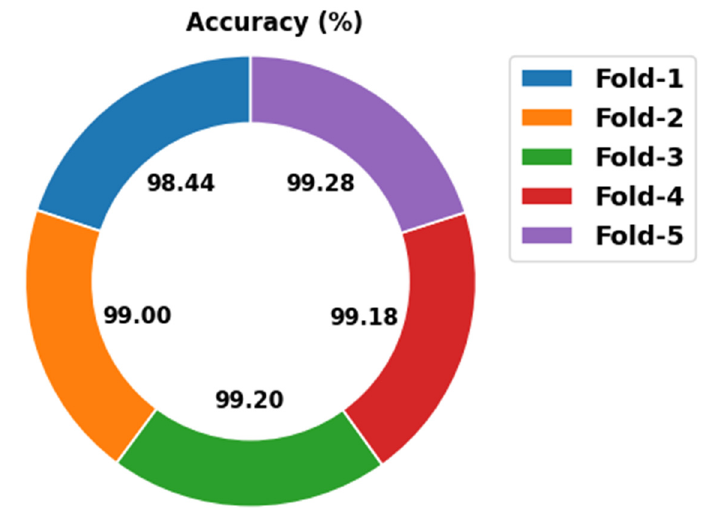
Figure 5. Average accuracy analysis of ODAE-WPDC approach with distinct folds.